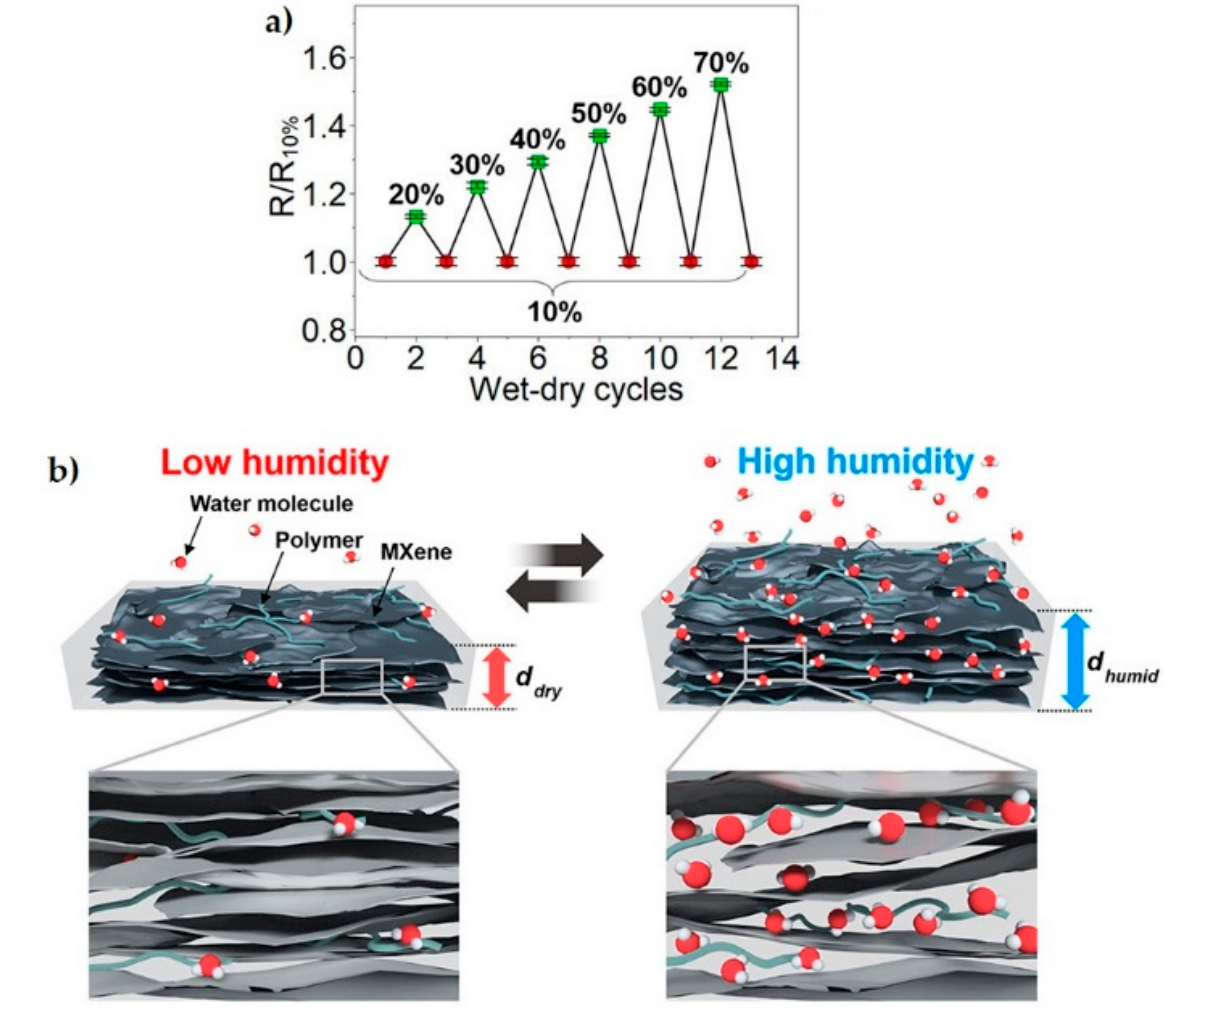
Figure 9. ( a ) Ratio between the tunneling resistance at a fixed value of the relative humidity (indicated in the plot) and the tunneling resistance at a relative humidity of 10%. ( b ) Sketch of the proposed response to the humidity of the MXene-PDADMAC films. Reprinted with permission from Ref. [137]. Copyright 2019 American Chemical Society.